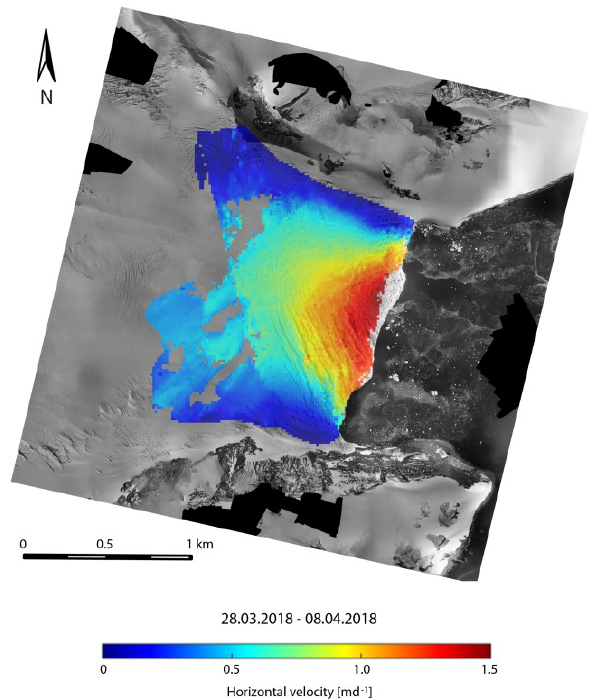
Figure 6: Color-coded merged velocity field obtained from both sides of the glacier Figure 7 shows a surface velocity field determined from Sentinel 1-B satellite radar image data (Cardenas et al., 2020; Johnson et al., 2020), which was obtained through the ‘offset tracking’ processing module from SNAP©, an open access software from the European Space Agency (ESA). The results are in good coincidence with the validation data determined from the terrestrial cameras.